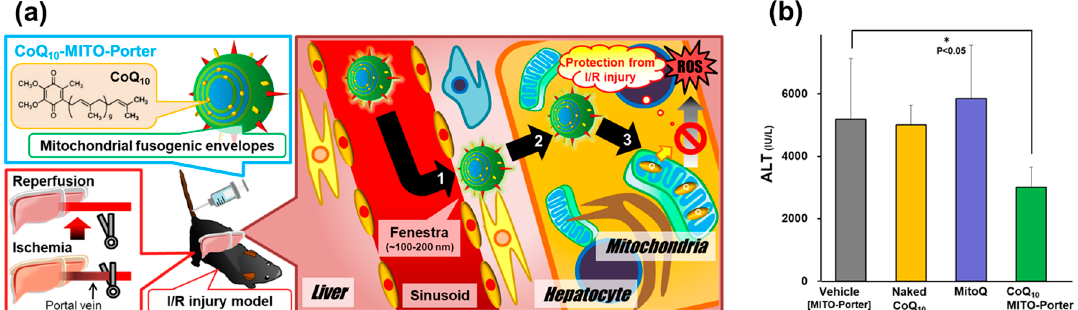
Figure 6. Overview of prevention of the hepatic ischemic reperfusion injury (IRI) by MITO-Porter system [86]. ( a ) Schematic image of antioxidant therapy by mitochondrial delivery of CoQ 10 using MITO-Porter. ( b ) Evaluation of therapeutic e ff ect of CoQ 10 -MITO-Porter. Serum alanine transaminase (ALT) activities were measured after the hepatic IRI. Data are represented as the mean ± S.D. ( n = 4). Significant di ff erence between vehicle and others was calculated by one-way ANOVA, followed by Bonferroni test. These figures are reproduced with permission from Elsevier.